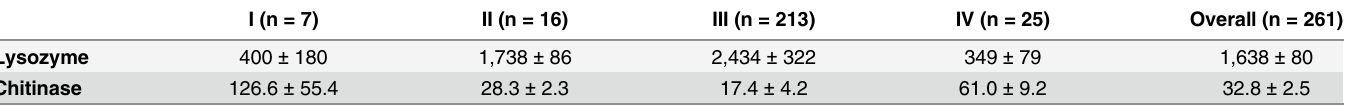
Table 3. Salivary lysozyme activity and chitinase activity stratified by Spectral Clustering clusters (Values expressed in Units of activity ml -1 , mean ± standard